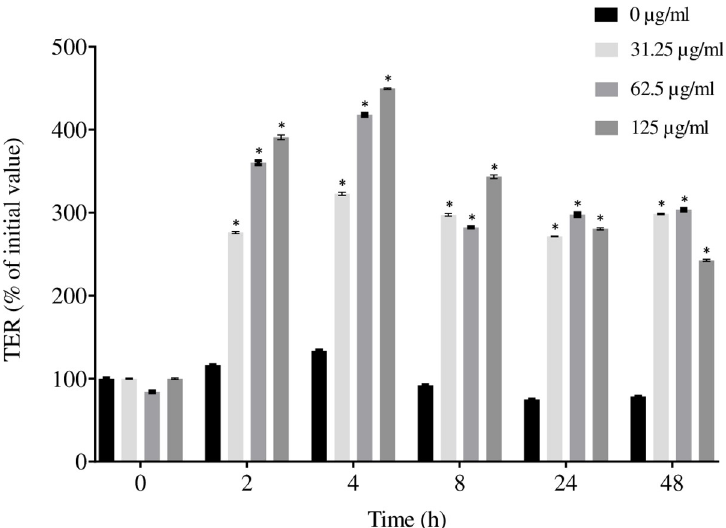
Fig 5. Effect of the cocoa extract on oral epithelial tight junction integrity. Time- and dose-dependent effects of the cocoa extract on TER values in oral epithelial cells (B11 cell line). A 100% value was assigned to the TER value at time 0. � , significant increase ( p < 0.01) compared to the control (no cocoa